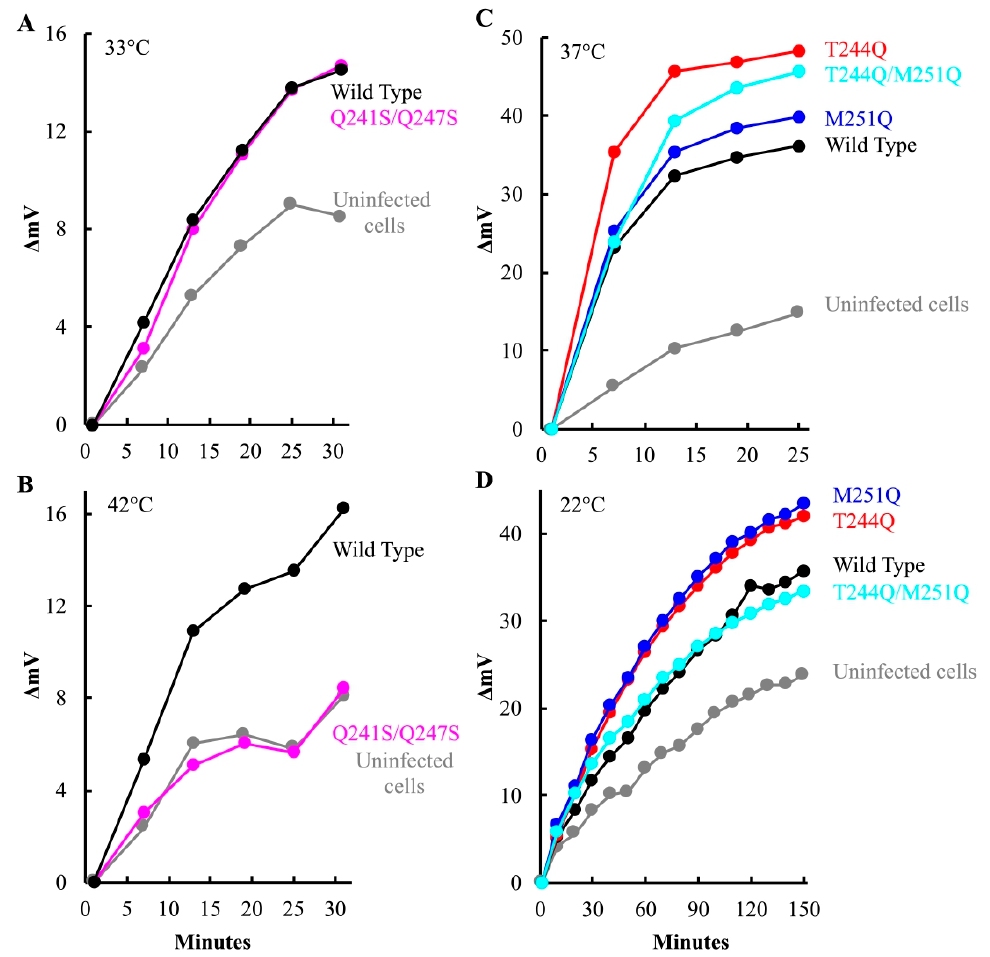
Figure 6. Potassium efflux curves produced by mutant H infected cells. Efflux values are reported as the increase in millivolts after the initial millivolt reading ( Δ mV). Increasing positive values indicate increasing extracellular [K + ]. The infection temperatures and H proteins found in the infecting virions are given in the figure.